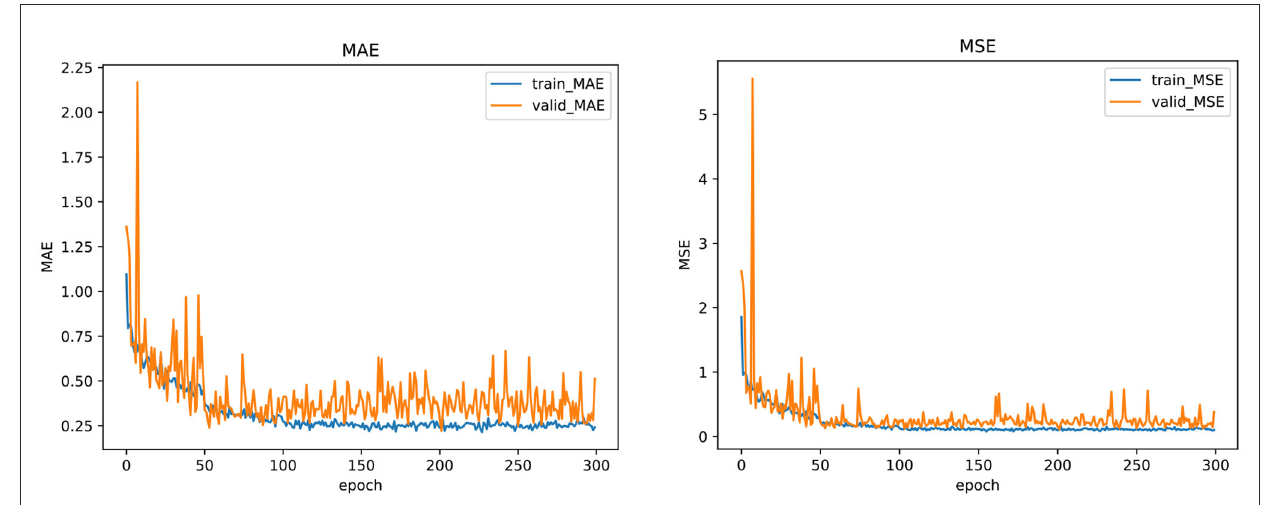
FIGURE3 The training curve of the regression loss in our multi-task